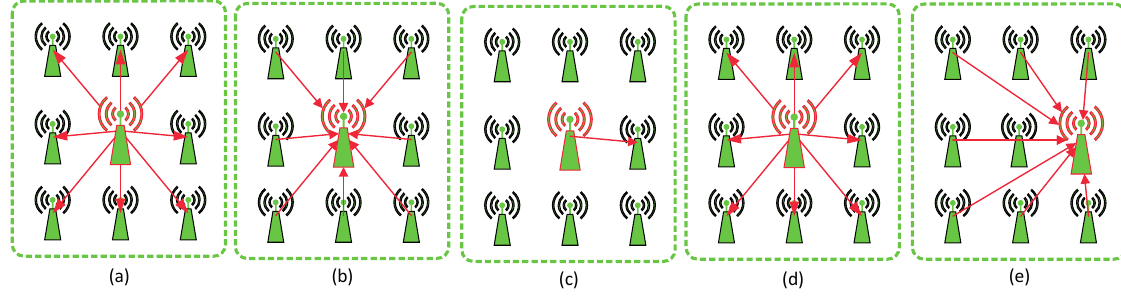
Figure 2. The VA model process. ( a ) The cluster head notifies the beginning of an auction; ( b ) Each node bids a value based on its remaining energy; ( c ) The winner of the auction is designated as the cluster head in the next round, and related information is sent from the original cluster to it; ( d ) The original cluster head broadcasts the result of the auction; their data to the new cluster